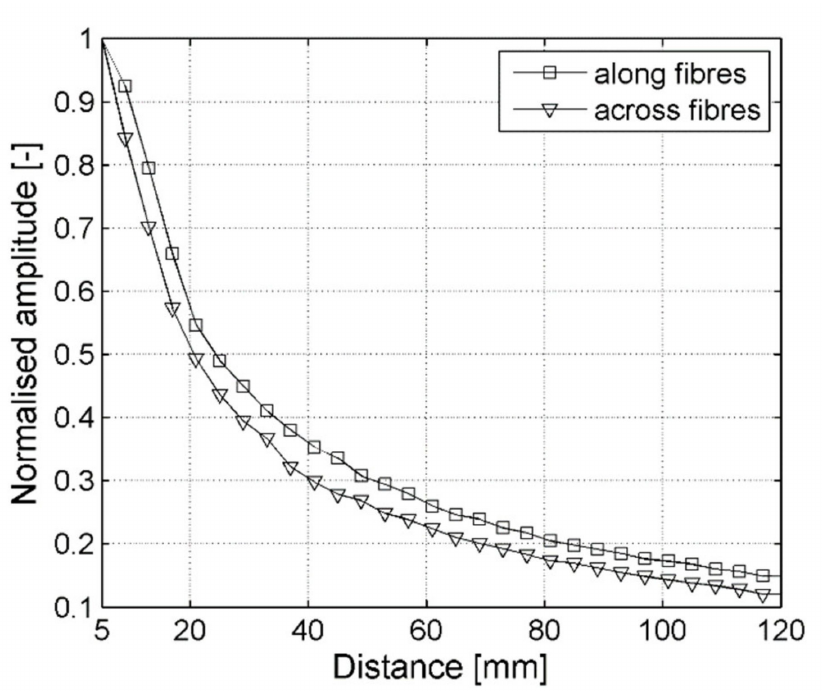
Figure 8. Normalized elastic waves amplitude in the direction along and across reinforcing